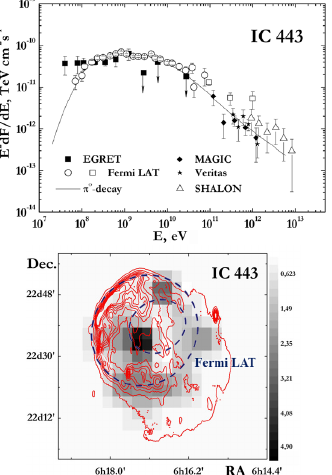
Figure 4. Characteristics of IC443: top: Spectral energy dis- Figure 2. Characteristics of Tycho’s SNR: top: Spectral energy tributions of high- and very high energy γ -ray emission by distributions of high- and very high energy γ -ray emission by SHALON ( ) compared with other experiments. The line is the SHALON ( (cid:31) ) in comparison with other experiments. Lines show (cid:31) γ -ray energy flux from π ◦ -decay. bottom: Image of SNR at en- the gamma-ray spectra calculated for four distances d and the ergies > 0 . 8 TeV by SHALON (grey scale). Contours are 1420 corresponding densities of the interstellar medium N H . bottom: MHz radio structure by Canadian Galactic Plane Survey DRAO. Image of SNR in the energy range 0 . 8 80 TeV by SHALON − Radio contours are linear and correspond to 6.5%, 13%, 19.5% (grey scale). Red contours are the X-ray emission by Chandra. and 60% of the emission map maximum. Contour levels are 0.8% 2.2%, 6.2%, 18% and 51% of the X-ray emission map maximum.